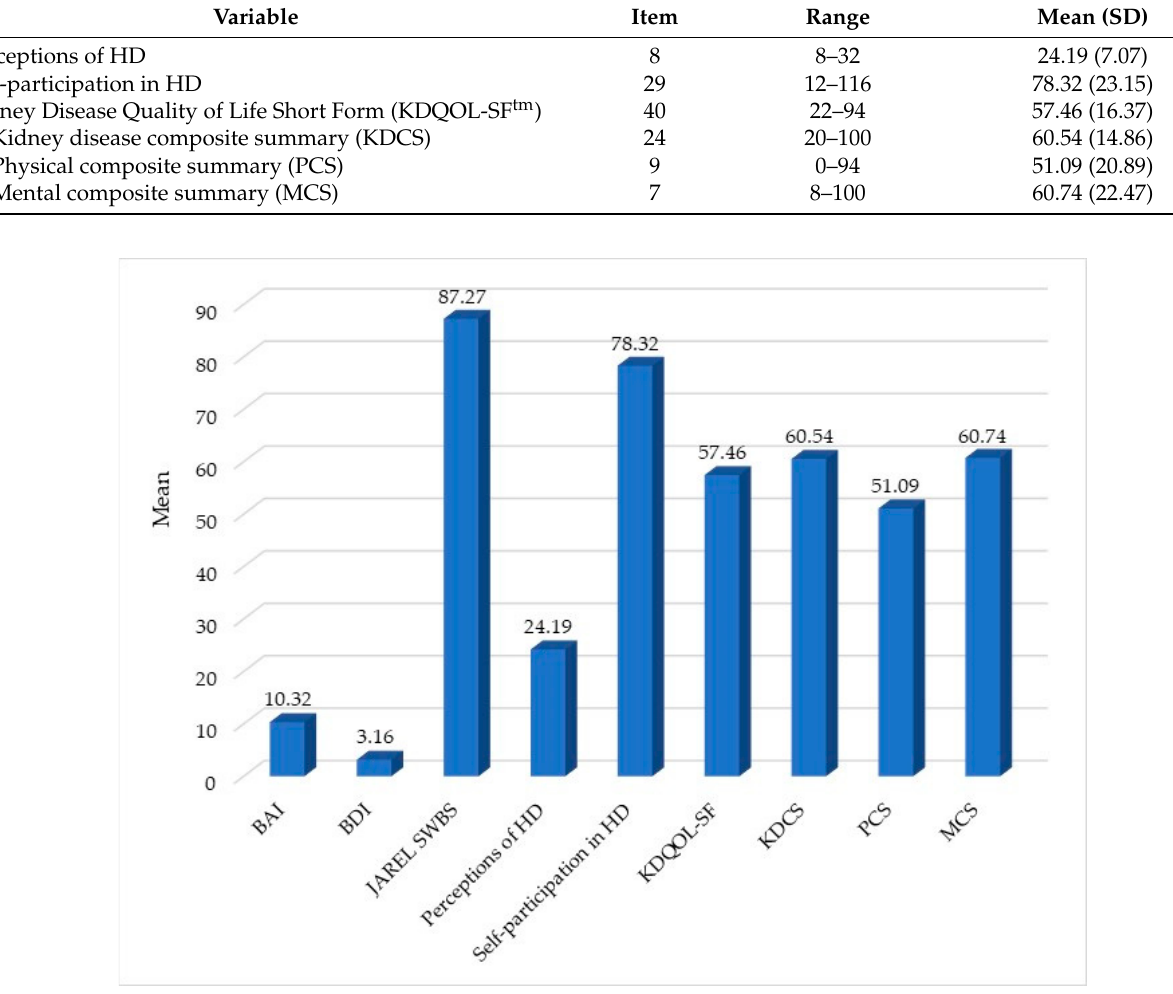
Figure 2. Means of variables .